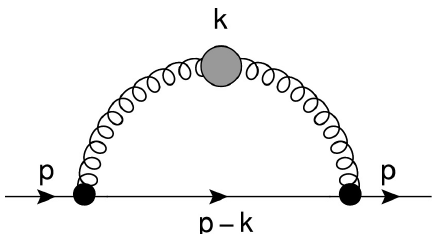
Figure 2. The interaction rate is obtained from the imaginary part of the self-energy, whose kinematics are defined by the one-loop self-energy quark diagram used to compute the interaction rate. The gluon line with a blob represents the effective gluon propagator at finite density and temperature. The blobs on the quark–gluon vertices represent the effective coupling between the quark spin and the thermal vorticity. The figure is taken from Ref.